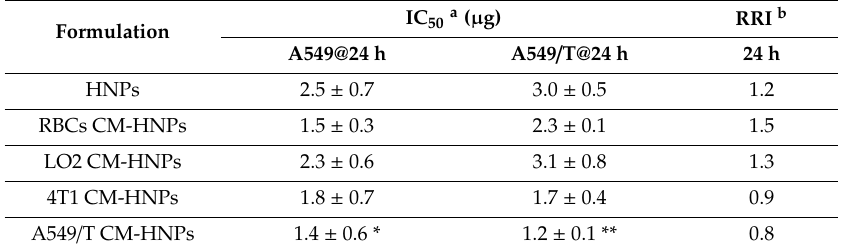
Table 2. Cytotoxicity of different formulation in A549 and A549/T cells after 24 h of incubation. Formulation